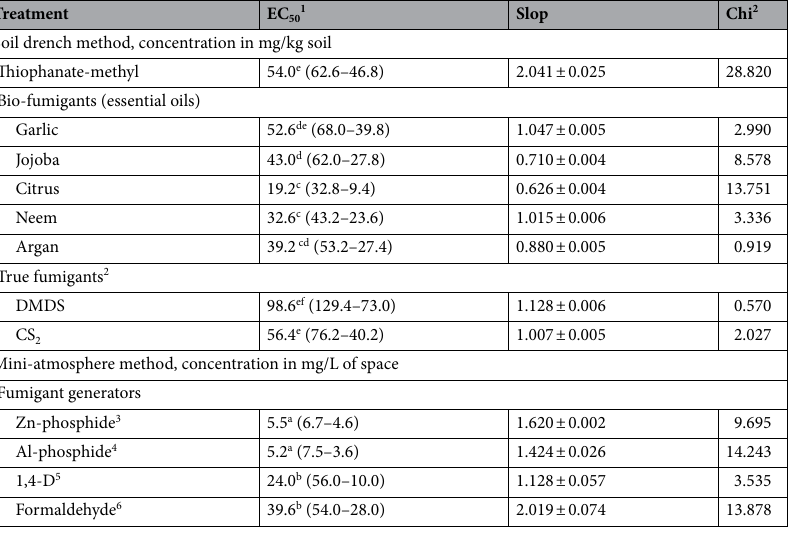
Table 2. Effect of tested fumigants on fusarium in soil using drench method for true- and bio-fumigants and mini-atmosphere method for fumigant generators under greenhouse conditions. 1 Median effective concentration calculated from growth inhibition data, values marked by the different letters in the column indicate a significant difference at P ≤ 0.05. 2 Dimethyl disulphide (DMDS), Carbon disulphide (CS 2 ). 3 Zn-phosphide was mixed with HCl 1N (1:5), 1 mg Zn-phosphide produces 0.24 mg PH was mixed with HCl 1N (1:5), 1 mg AL-phosphide produces 0.32 mg PH 3 . 5 It was generated from 1,4-dichlorobenzene (100%). 6 Formaldehyde was generated from formalin 40% + KMnO 4 (1:3), 1 mL formalin produces 0.40 g